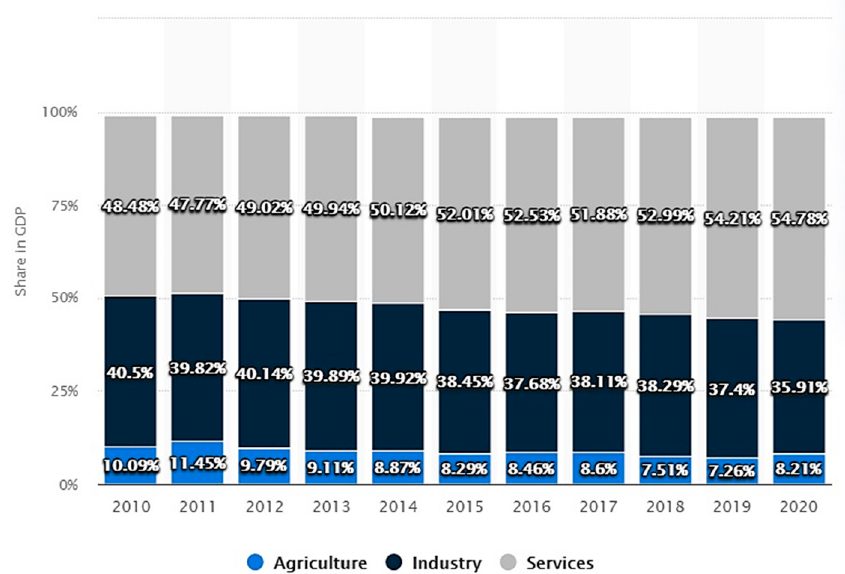
Figure 1. Malaysia: share of economic sectors in the GDP from 2009 to 2020.